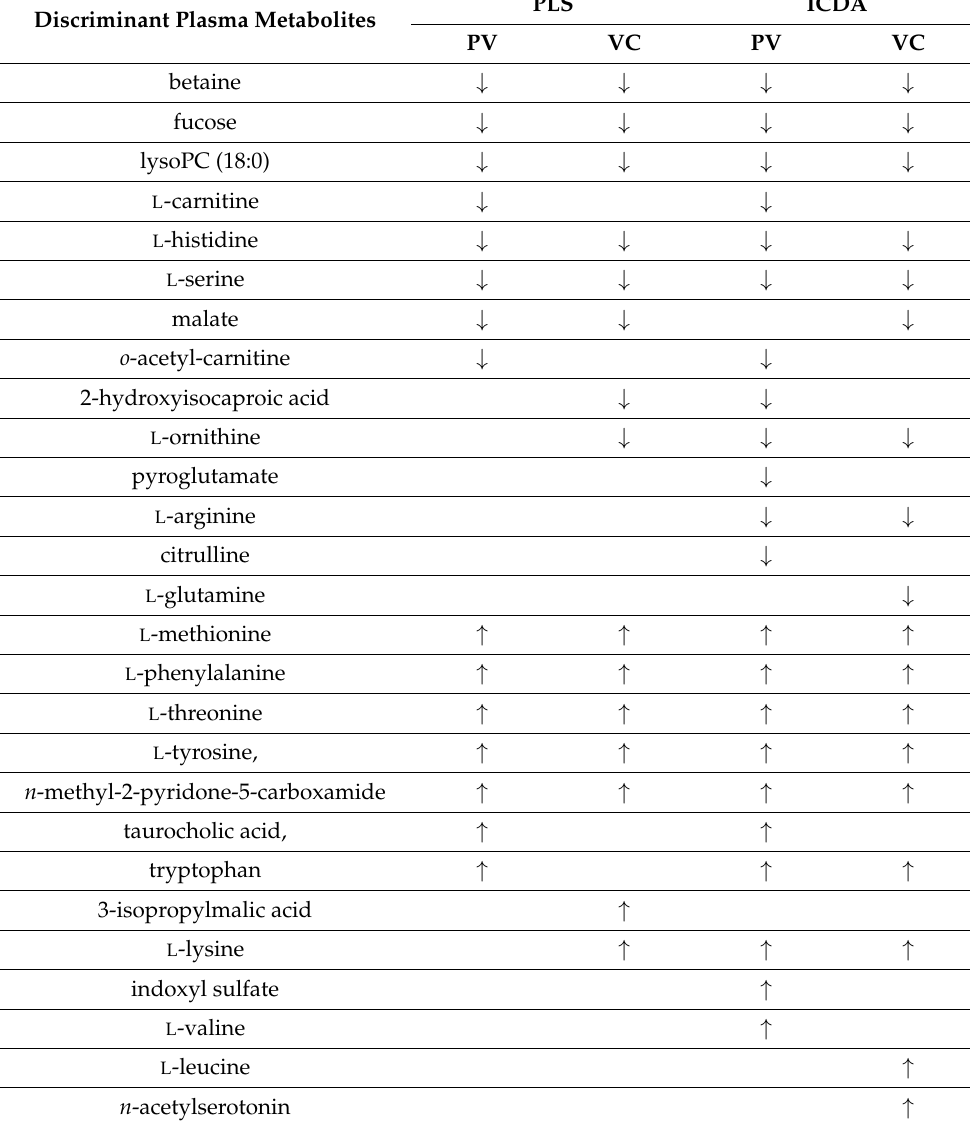
For vena cava plasma, twenty-two discriminant molecules were observed between groups. Fifteen molecules were statistically significant after ANOVA test (Table 3